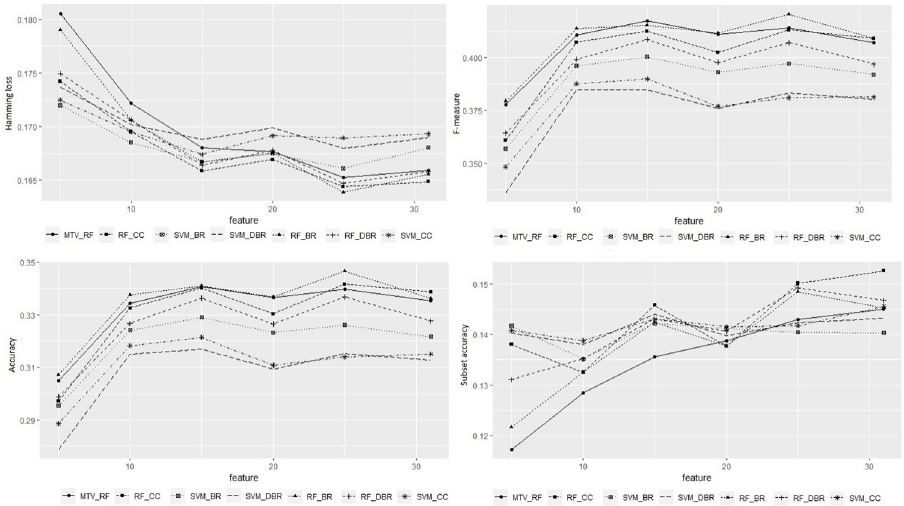
Fig 2. Performance of multilabel classifiers according to the number of features. MTV- multivariate; RF-Random Forest; CC- Classifier Chain; SVM- Support Vector Machine; BR- Binary Relevance; DBR- Dependent Binary Relevance.